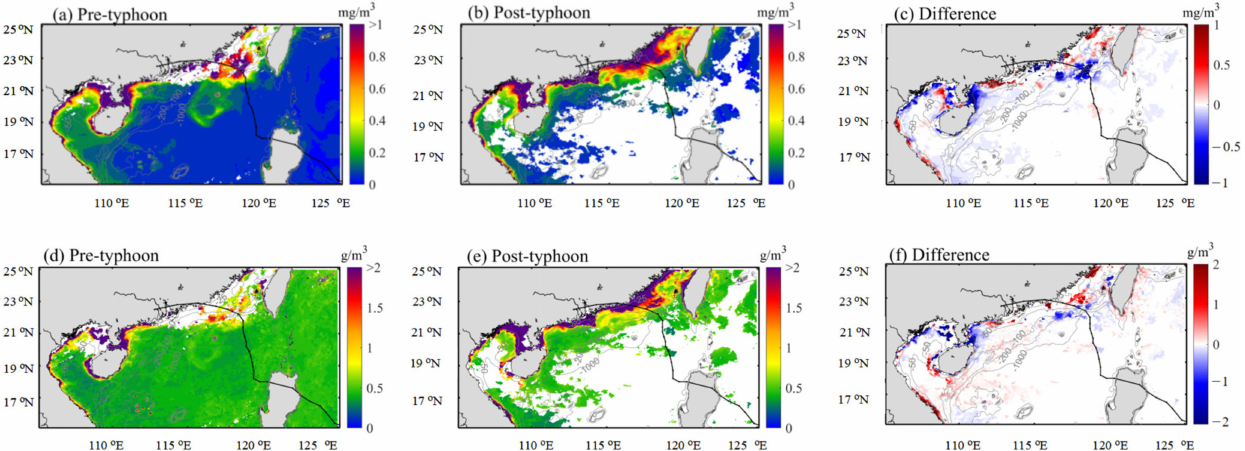
Figure 3. Spatial distribution of Chlorophyll- a ( a – c ) and SPM ( d – f ) concentrations during pre-typhoon (one week) and post-typhoon (one week). The gray line represents the water depth (25 m, 50 m, 100 m, 200 m, 1000 m). The black line denotes typhoon path.